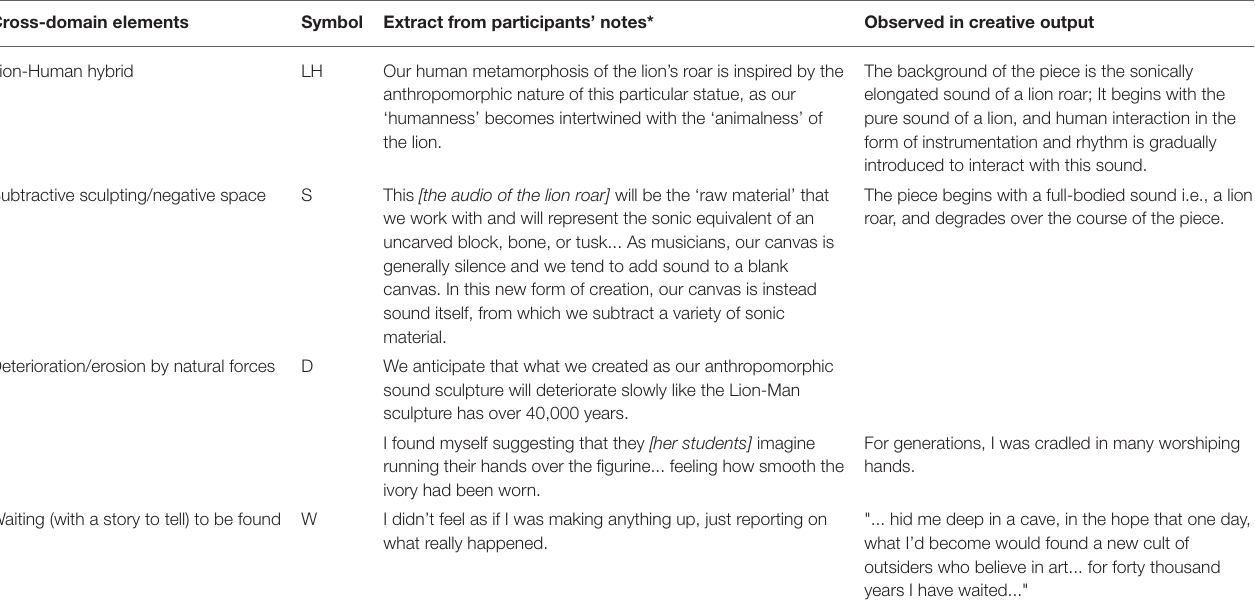
TABLE 3 | *These are a sample from notes made by participants. Cross-domain elements Symbol Extract from participants’ notes* Lion-Human